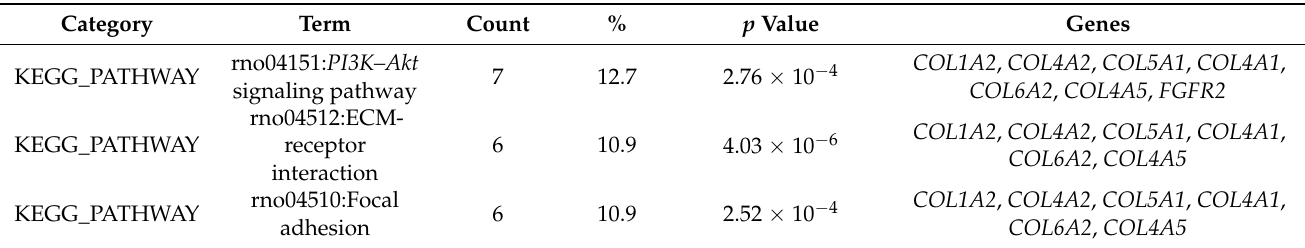
Table 7. Top three KEGG pathways significantly enriched in DEGs related to anti-apoptosis in NK-5962-treated retinas (DAVID).